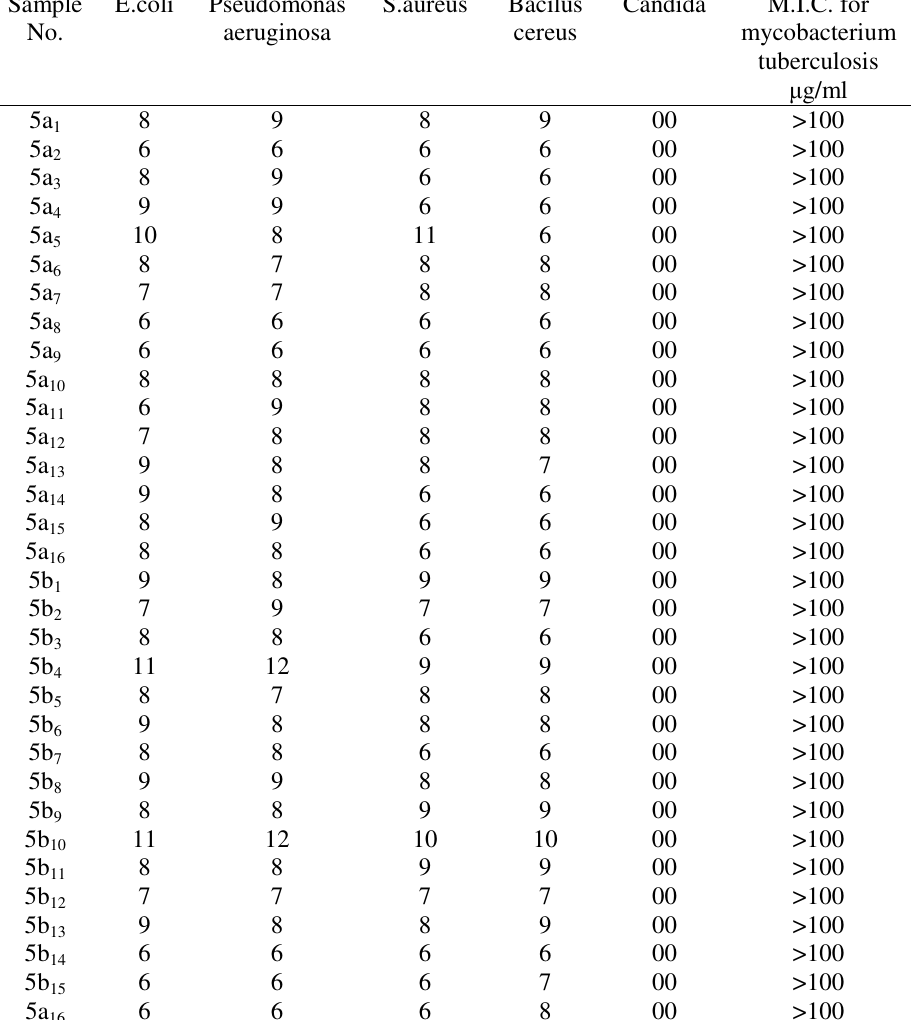
Table 3.Antimicrobial Activity of Newly Synthesised Compounds, Zone of Inhibition (Mm)